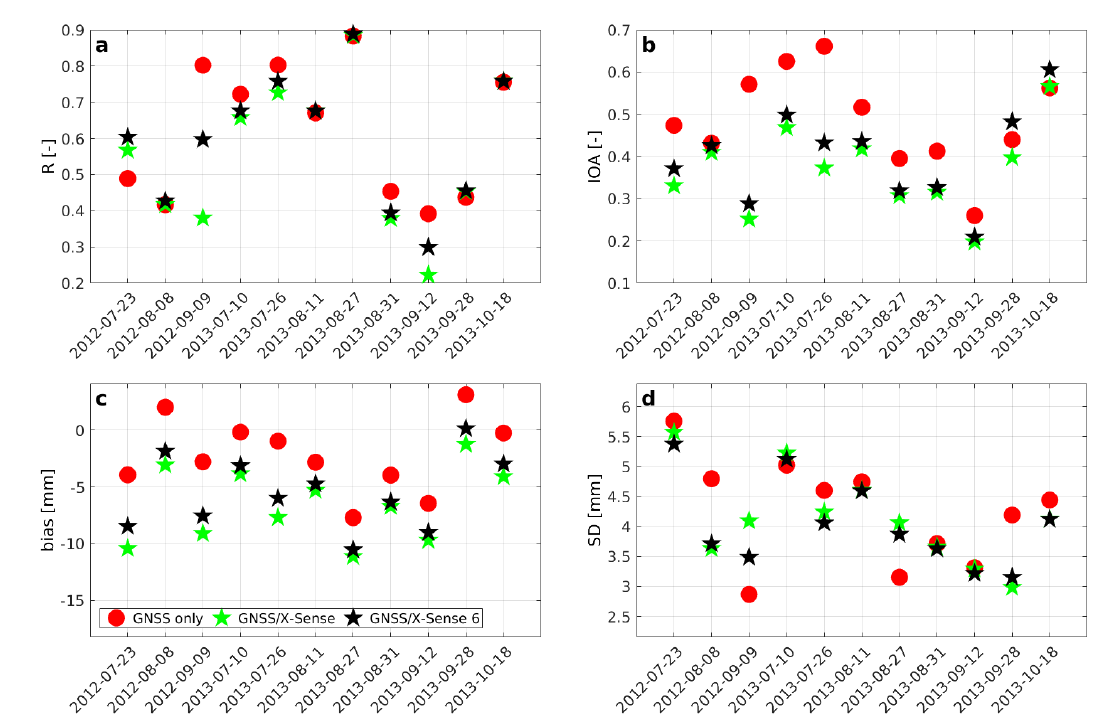
Figure 11. ( a ) correlation coefficients ( b ) IOA ( c ) bias and ( d ) SD s of the differences between InSAR and three data sets: ‘GNSS only’ (red dots), ‘GNSS/X-Sense’ (green stars), ‘GNSS/X-Sense 6’ (black stars) averaged over the entire study area for 11 acquisitions that corresponds to the availability of the X-Sense